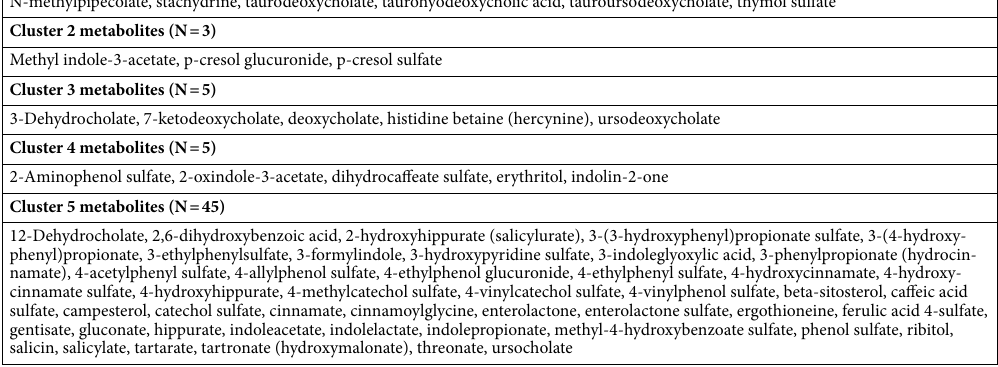
Table 3. MDPs by cluster from the hierarchical clustering on Spearman’s correlation. Spearman’s coefficients for each metabolite are presented in Supplemental Table S3, and are depicted in Fig. 2c. N = 9 control and N = 8 alcohol-treated